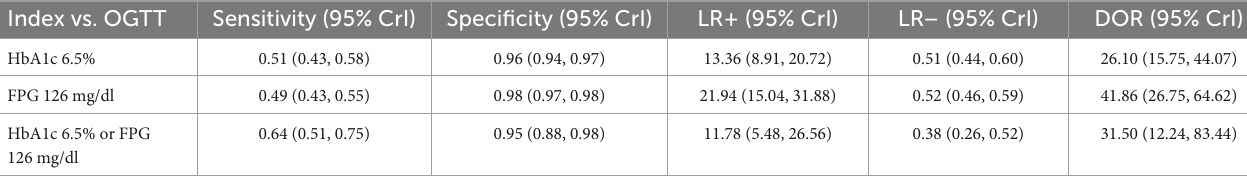
TABLE 1 Performance of index tests versus OGTT.